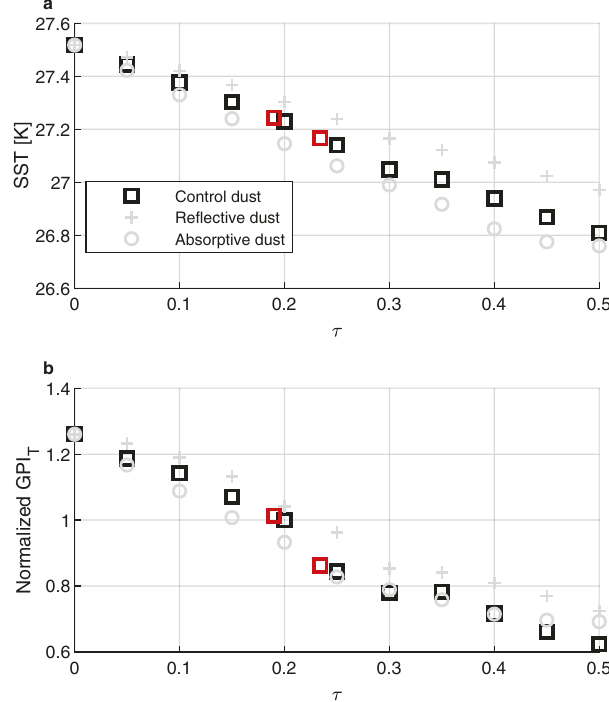
Fig. 3 | Sensitivity of sea-surface temperature (SST) and the thermodynamic component of the genesis potential index (GPI T ) to dust optical depth in the single-columnmodelsimulation.a SimulatedSSTand b GPI T asafunctionofdust opticalthickness( τ )at0.55 μ m,underaweaktemperaturegradientconstraint.The red dots are the values of SST and GPI T for dust concentrations representative of the1970s – 1980shurricanedrought( τ =0.23)andoftheentireperiodfrom1960to 2017( τ =0.19).Thegraypro fi lesrepresentsimulationswithsinglescatteringalbedo ( ω 0 ) perturbed so that the dust is more re fl ective ( ω 0 =0.94) or more absorptive ( ω 0 =0.84).Similarsimulationswheretheasymmetryparameter( ^ g )isperturbedto values of 0.58 and 0.78 yield similar results.